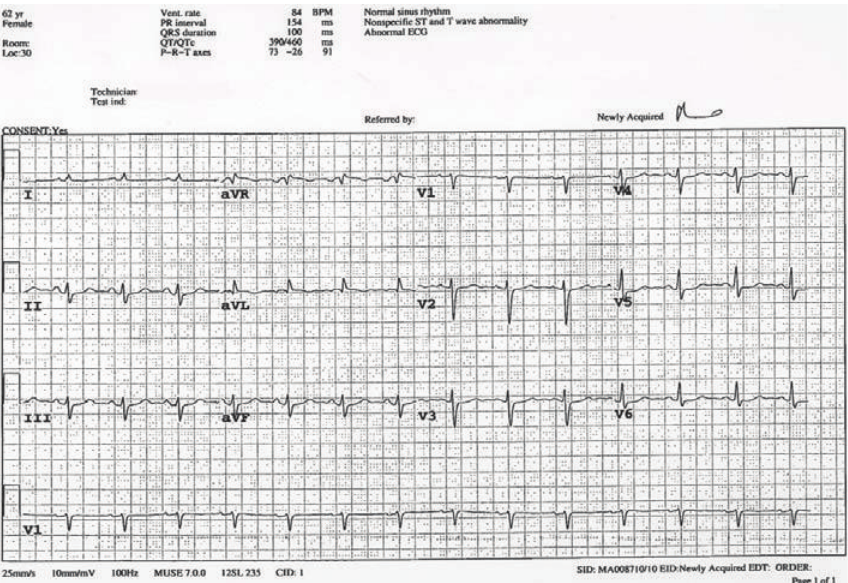
Figure 2: Subsequent 12-lead electrocardiogram performed after 24 hours shows resolution of ST segment